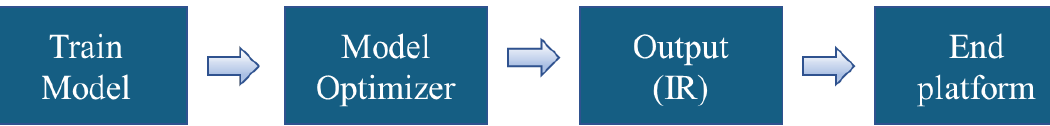
Figure 5. The flow of converting the trained model into intermediate representation (IR) format using model optimizer, where the IR format of the model is further used at the end platform.